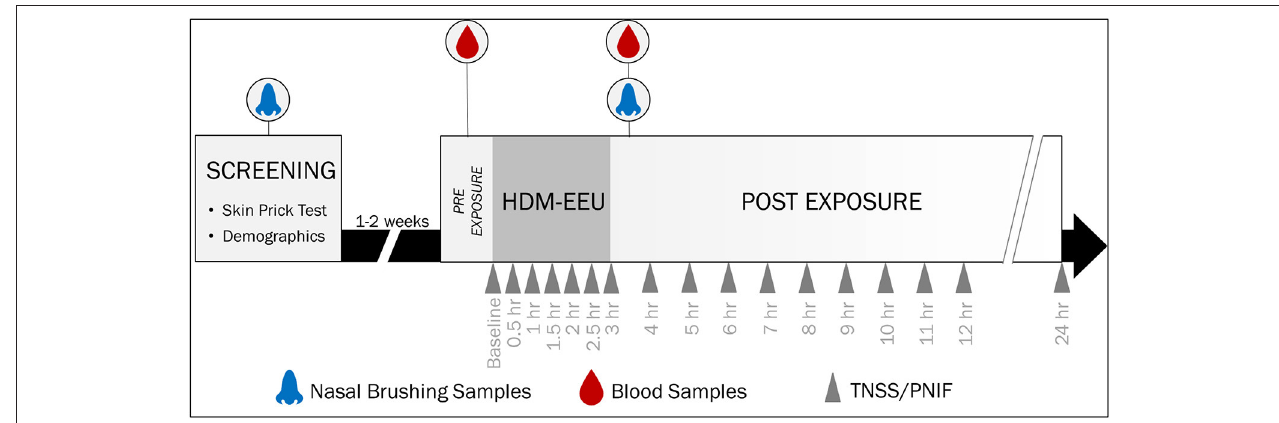
FIGURE 1 | Study Design and Sample Collection. Participants were recruited for a screening visit, where skin prick testing was completed to evaluate allergic sensitization to a panel of allergens. Eligible participants were invited to a modest or higher 3-h HDM exposure session in the HDM-EEU. Blood and nasal samples were collected pre- and post-HDM exposure. Hossenbaccus et al. (17).